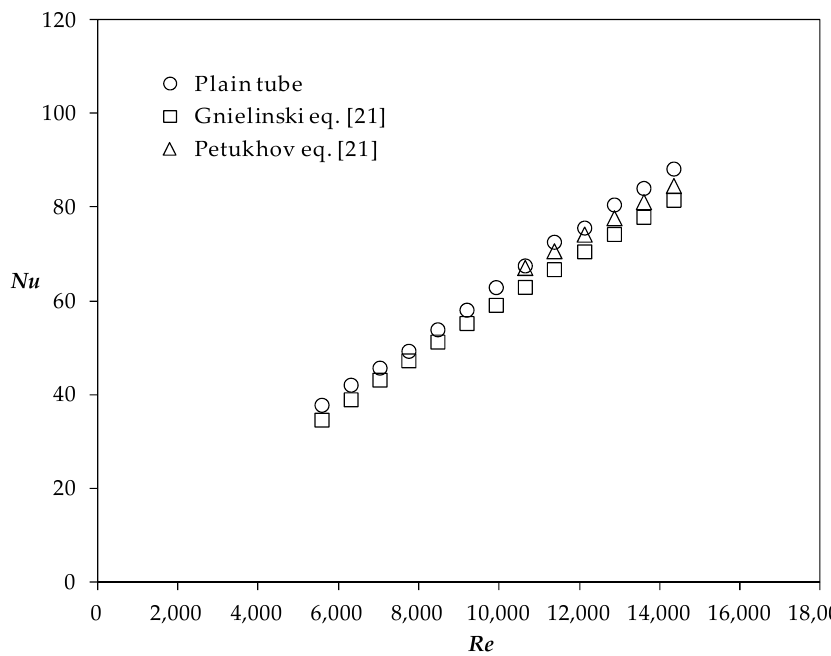
Figure 4. Validation of convective heat-transfer behavior of the plain tube.